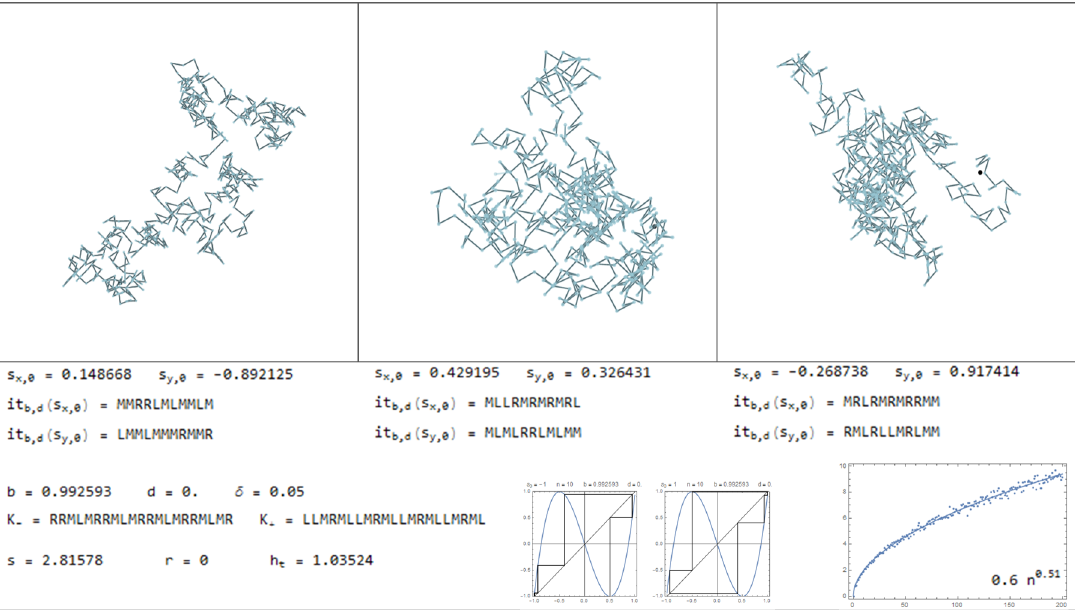
Figure 12. Trajectories produced with b = 0.992593 and d = 0.